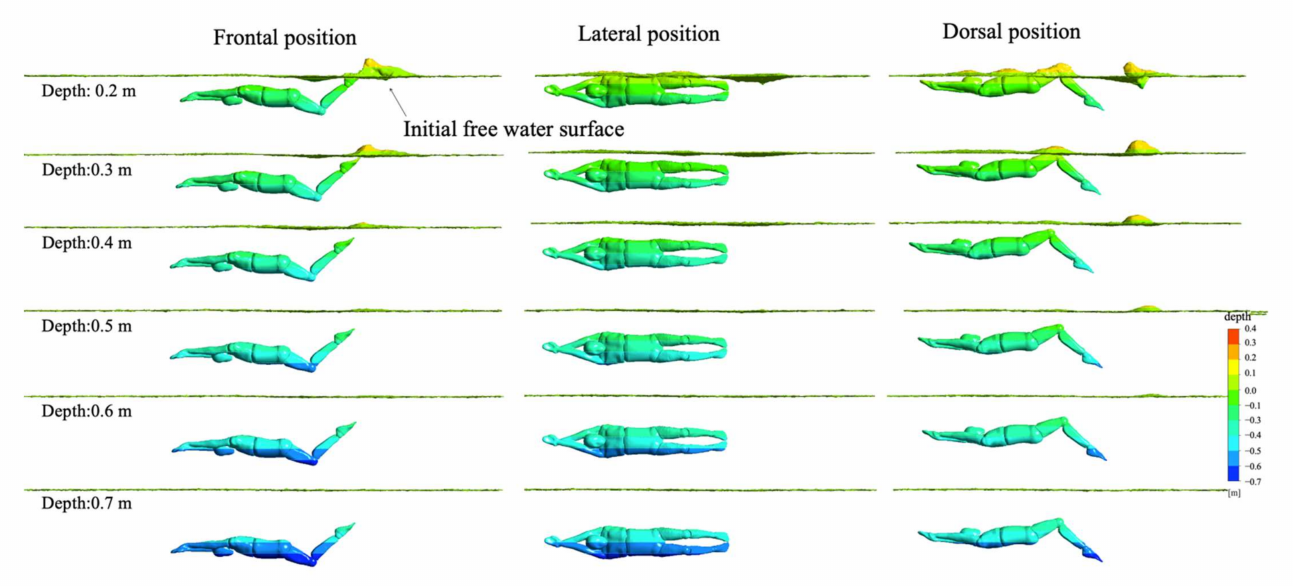
Figure 13. Transformation of water surface under different water